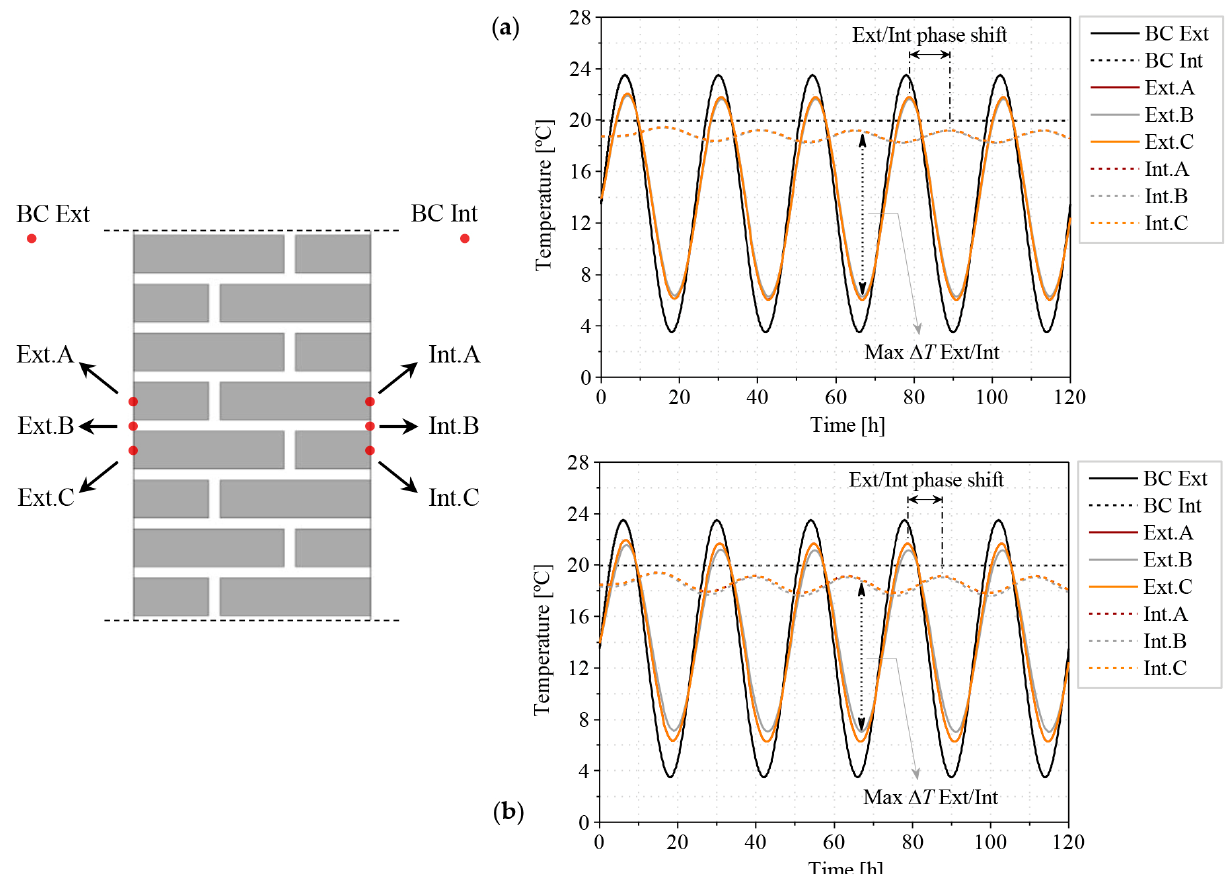
Figure 7. Time-dependent analysis with variable external boundary conditions (TD2). Temperature evolution for different points of the studied three-wythe brick masonry wall: ( a ) joints with natural hydraulic lime mortar (LM); ( b ) joints with cement mortar